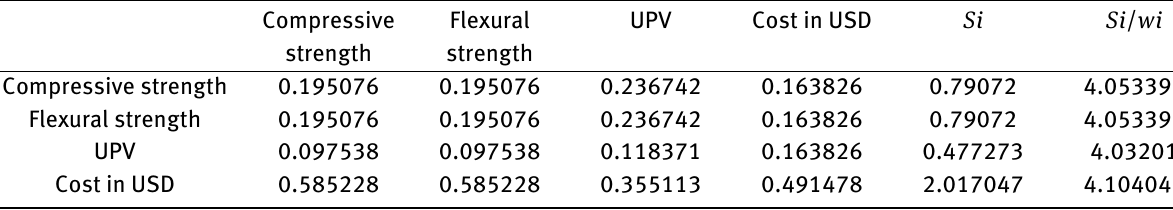
Table 15: Matrix Y for checking the pair-wise comparison matrix evaluated in AHP method.